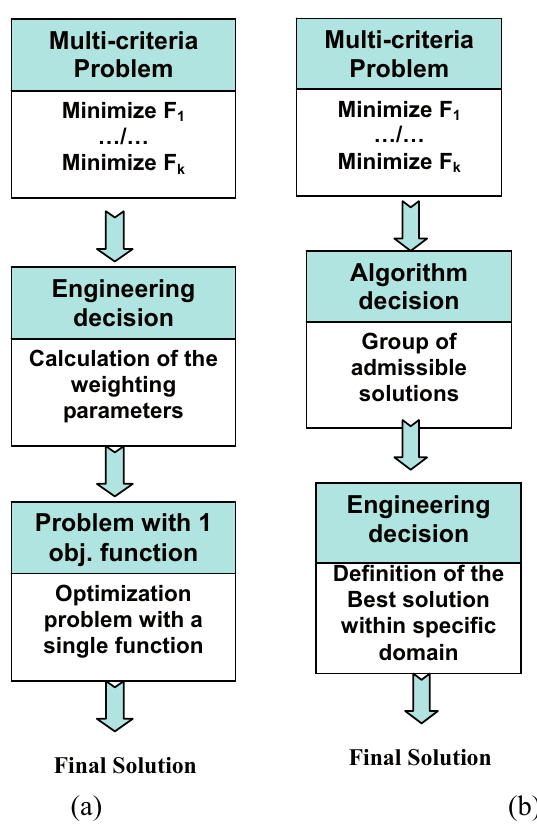
Fig. 2. Direct (a) and posteriori (b) methods for multicriteria